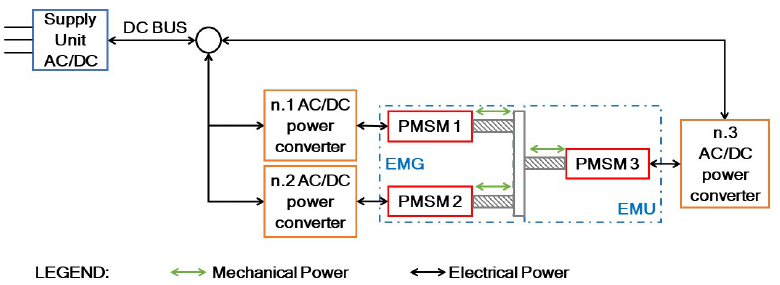
Figure 3. IMAGINE’s test rig layout (IMAGINE project,